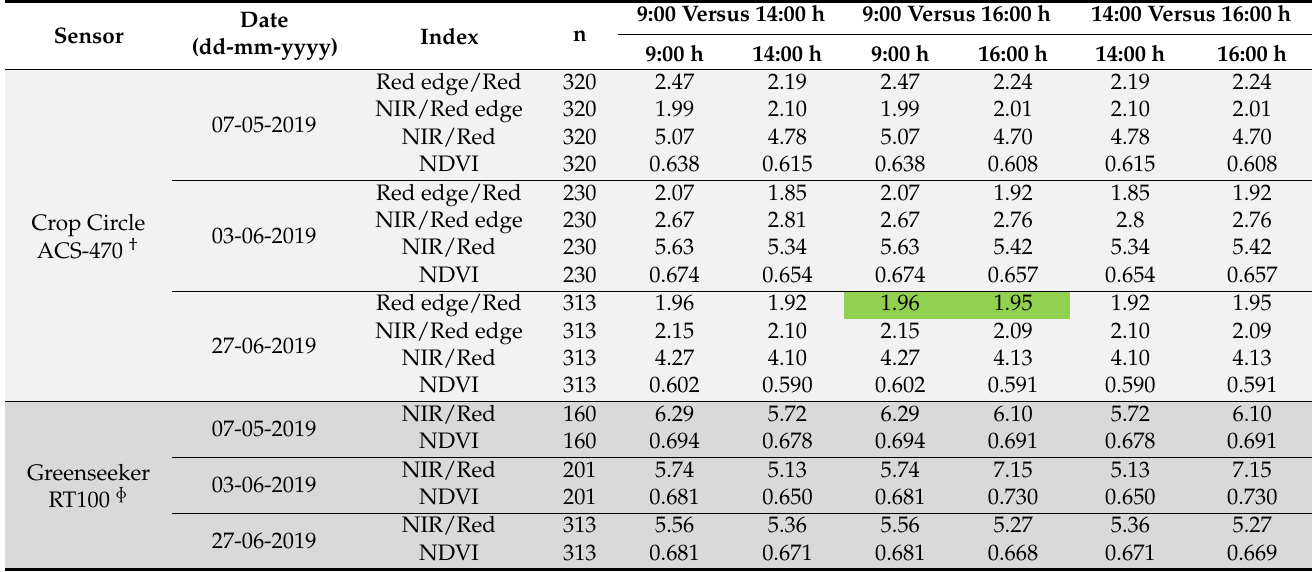
Table 4. Mean values of each vegetation index for paired measurement times (9:00 versus 14:00 h, 9:00 versus 16:00 h, and 14:00 versus 16:00 h) measured with two vehicle-carried active sensors, Crop Circle ACS-470 and Greenseeker RT100, on each date of measurement. Green shading indicates non-significant differences between paired measurement times using t-Tests; all other pairs were statistically different ( p < 0.016, after Bonferroni correction for multiple comparisons). Backgroung color is necessary, since it allows to differentiate the two different sensors.